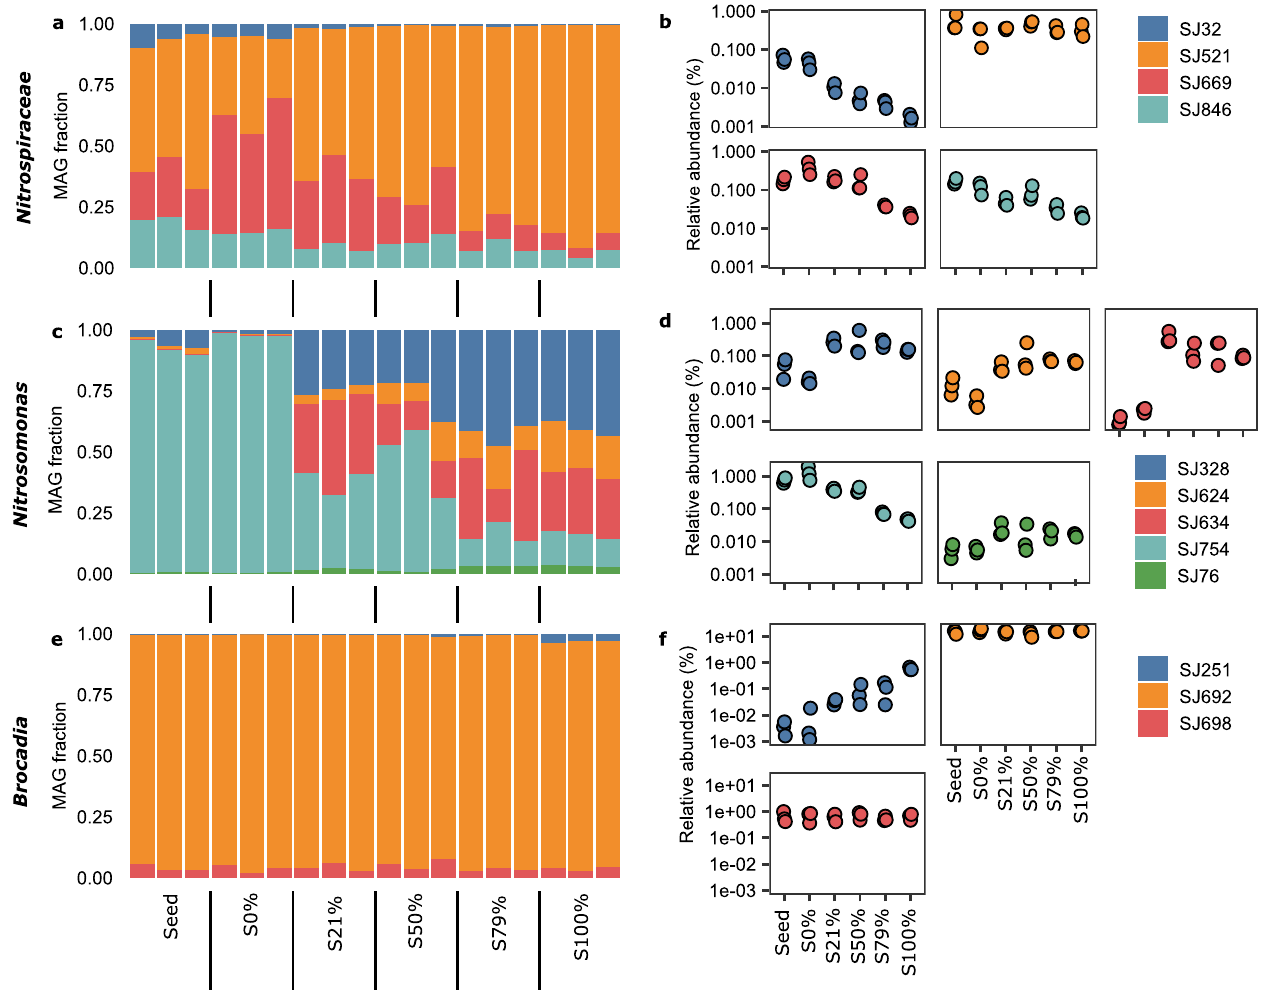
Fig. 5 Abundance of MAGs classi fi ed as Nitrospiraceae , Nitrosomonas and Brocadia . a , c , and e Relative abundance within the group. b , d , and f Relative abundance against all the bins in the